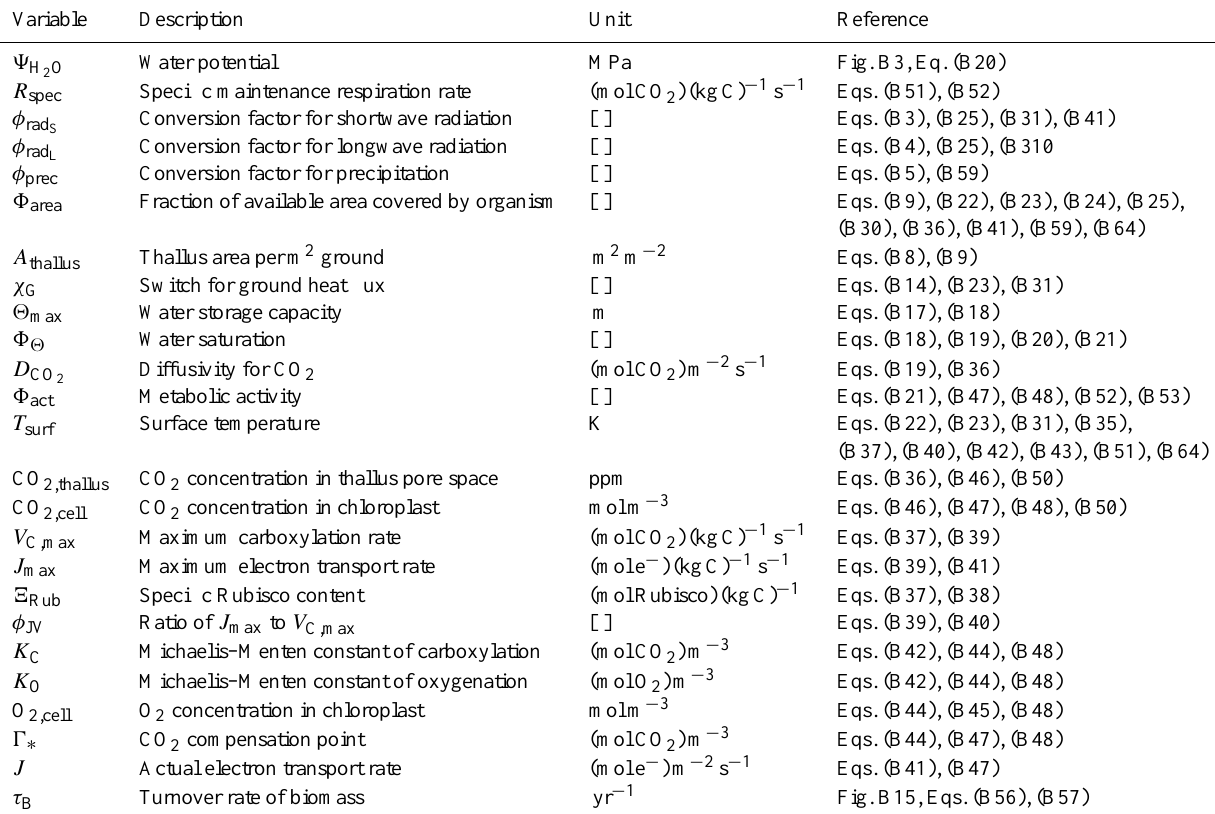
Table B16. Variables associated with lichens or